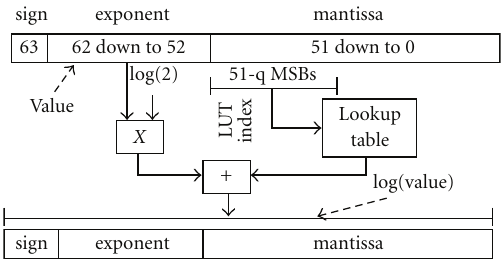
Figure 2: Outline of the ICSILog